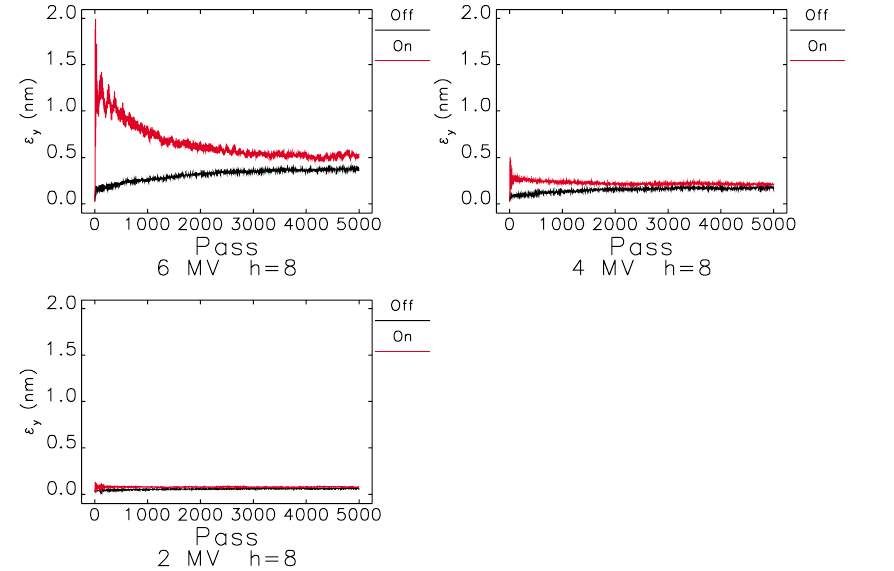
FIG. 13. (Color) Vertical emittance vs pass including synchrotron radiation effects, with interior sextupoles on and off.